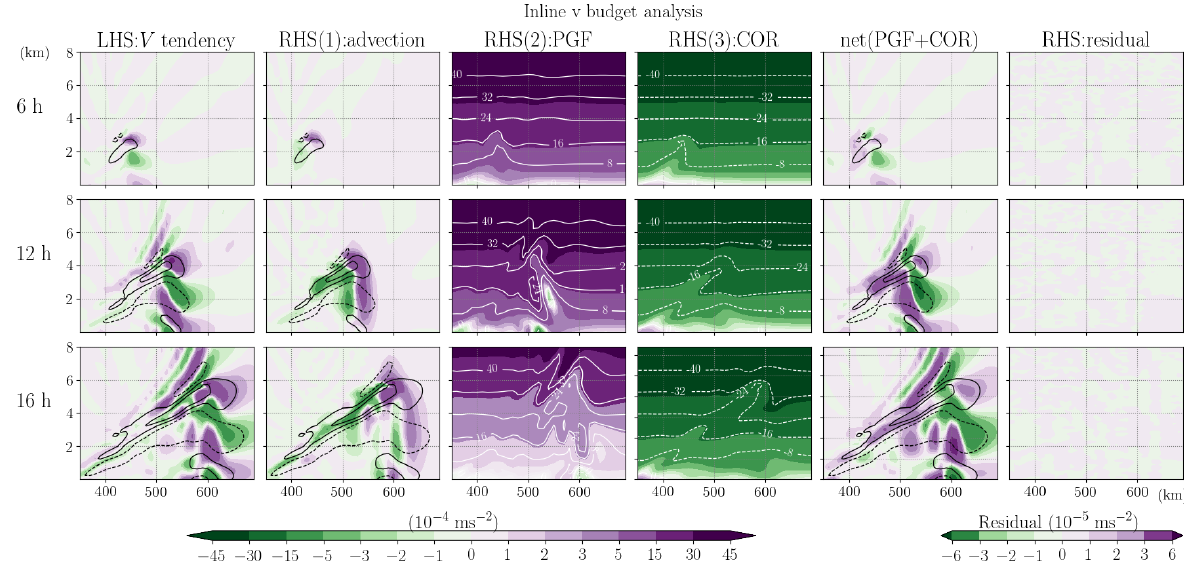
Figure 3. Inline budget analysis of horizontal momentum, V , with each term extracted directly from the model. In each row, the shading in each subplot from the left to right shows the term of V tendency, flux-form advection (ADV), horizontal pressure gradient force (PGF), Coriolis force (COR) (white contours indicate the values exceeding the color bar), PGF + COR, and residual (Eq. 1; P V is 0 and the generally small curvature term (CUV) is not shown). All terms are divided by µ d and thus have units of meters per second squared. The black contours indicate the horizontal velocity v of 2 and 6ms − 1 (positive and negative values shown in solid and dashed lines, respectively). Each row from top to bottom illustrates the budget analysis at 6, 12, and 16h, respectively.